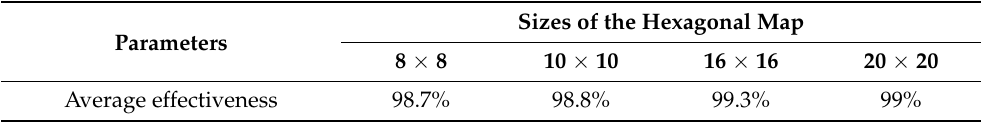
Table 6. Comparison of the effectiveness of the SOM-based fault detector with the neighbourhood radius equal 2 and the linkdist function for various sizes of the hexagonal